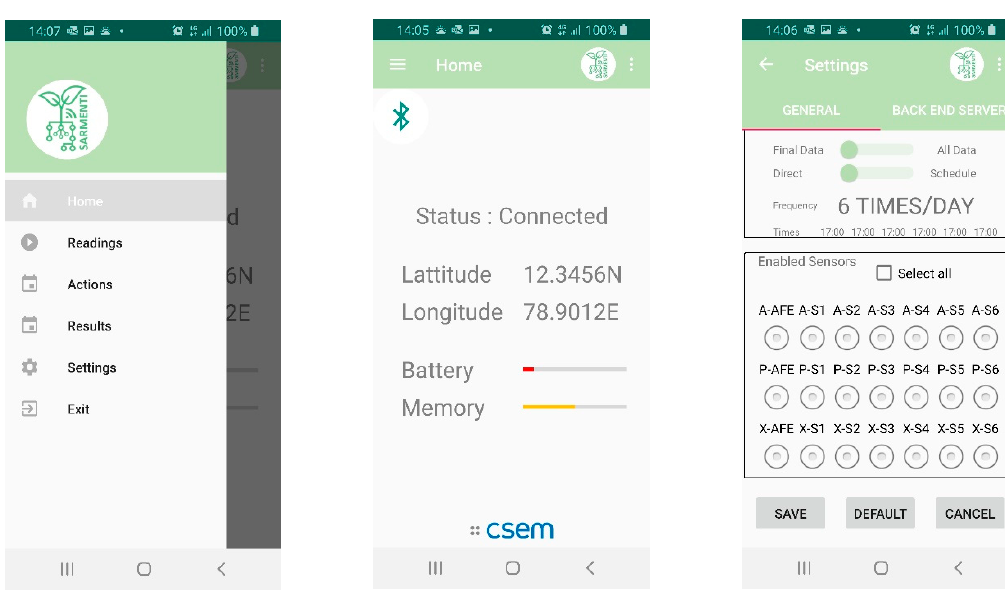
Figure 14. Smart Data Logger Bluetooth5 link to a Mobile Device .